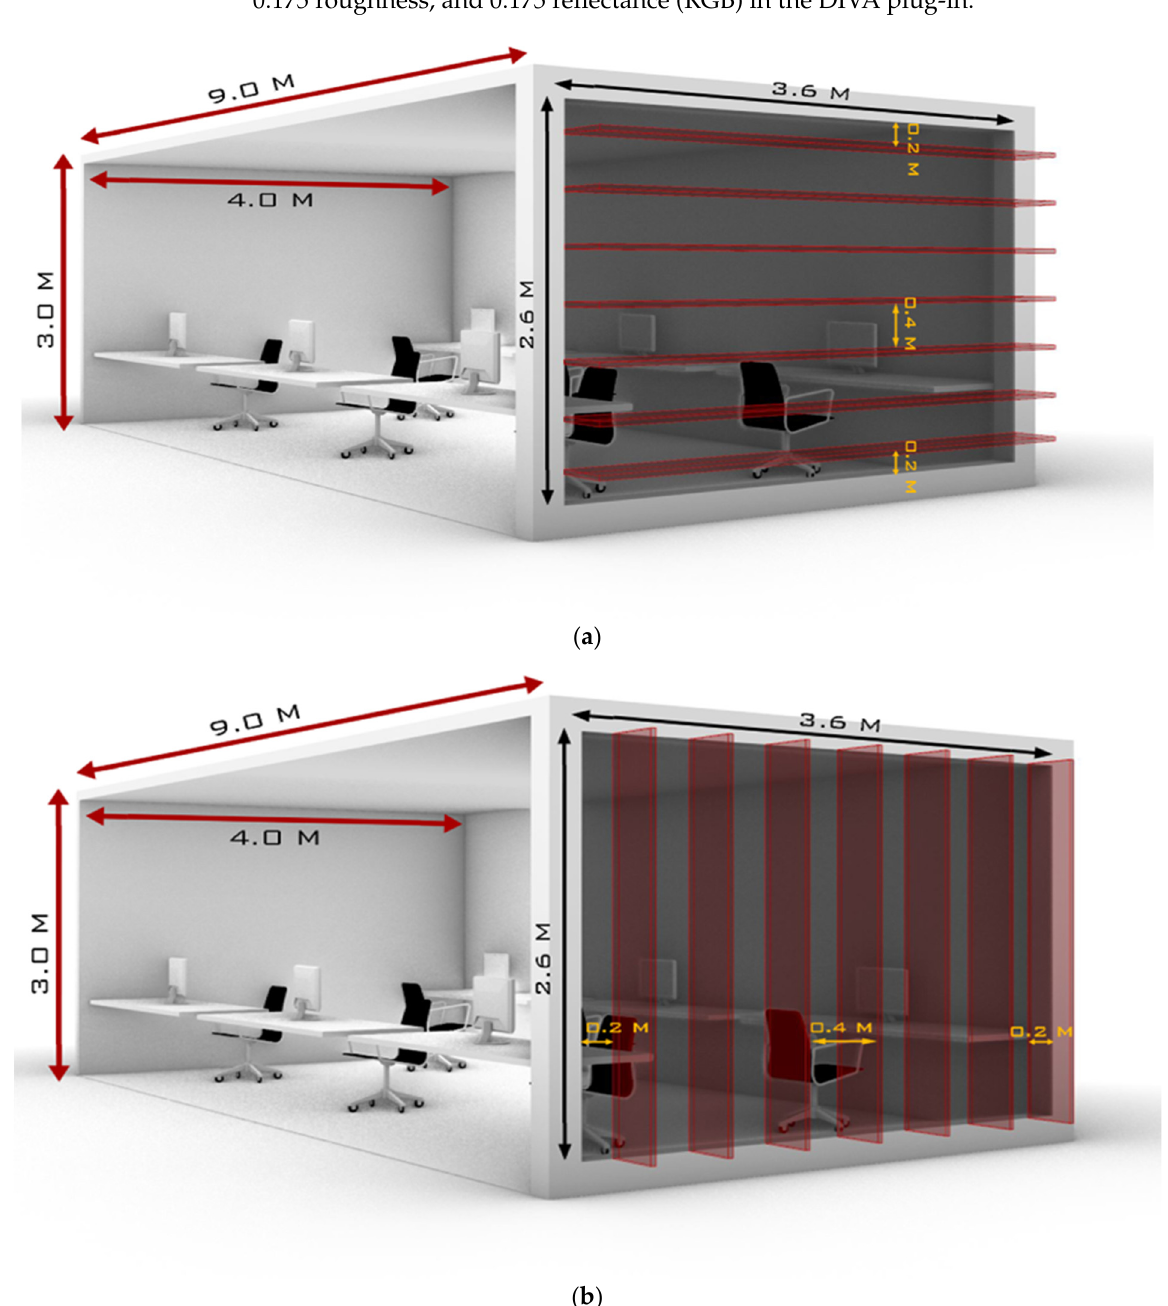
Figure 1. Standard south-facing office space with workstations. ( a ) Horizontal responsive louvers. ( b ) Vertical responsive louvers.